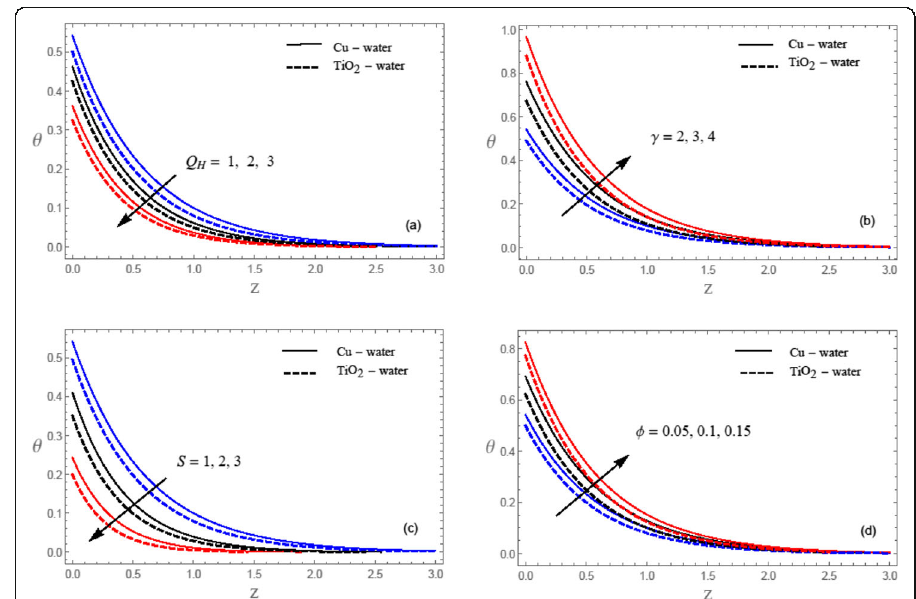
Fig. 4 a – d The temperature profile against Q H , γ , S , and ϕ